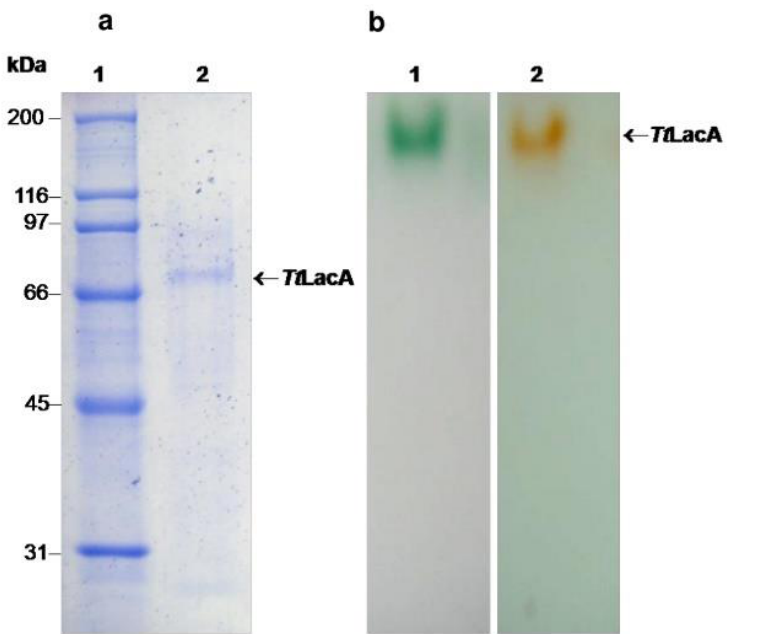
Figure 6. ( a ) Purification of Tt LacA of T. terrestris Co3Bag1. Lane 1, MW protein standards and lane 2, purified laccase. ( b ) Zymogram analysis of Tt LacA. Lane 1, ABTS and lane 2, 2,6-DMP,